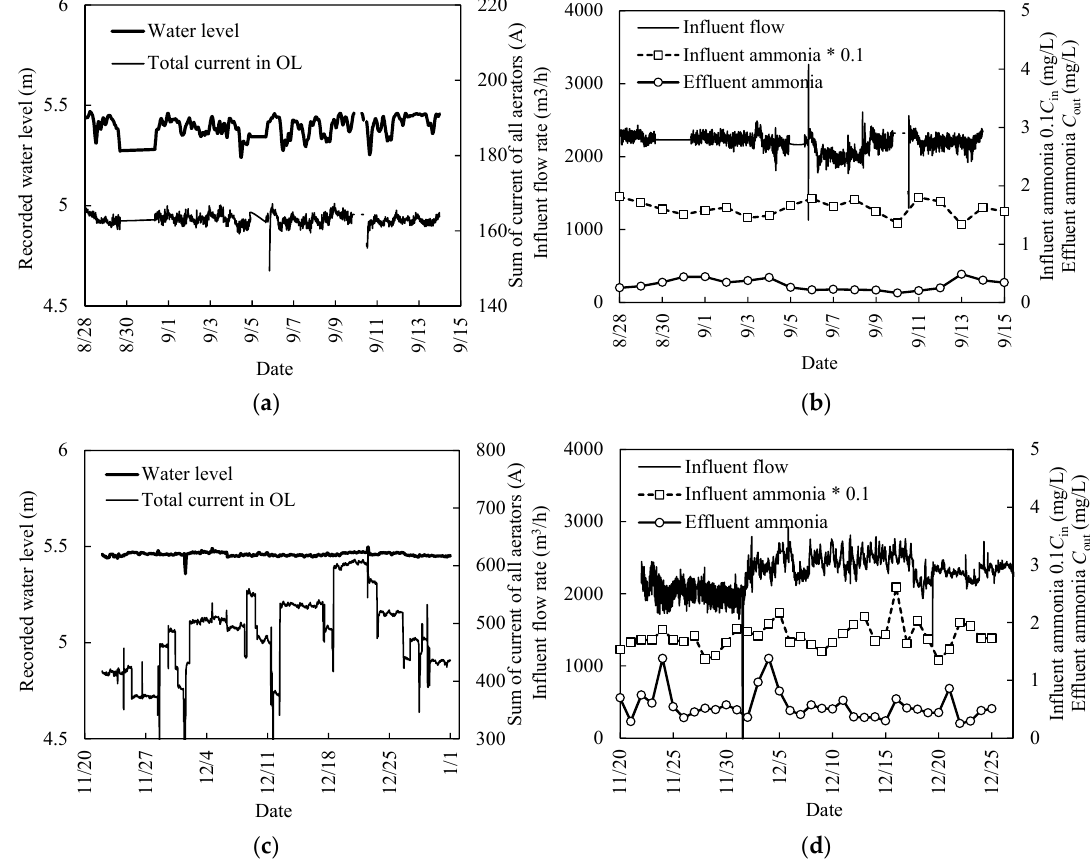
Figure 7. Process performances and electricity consumption with and without aeration control in the Orbal oxidation ditch in 2015. ( a ) water level and electricity current with control, and over the period the running numbers of rotators are fixed at constant; ( b ) influent flowrates, influent and effluent ammonia concentrations with control; ( c ) water level and electricity current without control, and over the period the running numbers of rotators are modified manually; ( d ) influent flowrates, influent and effluent ammonia concentrations without control. Curves of influent ammonia concentrations are zoomed in ten times for better vision.